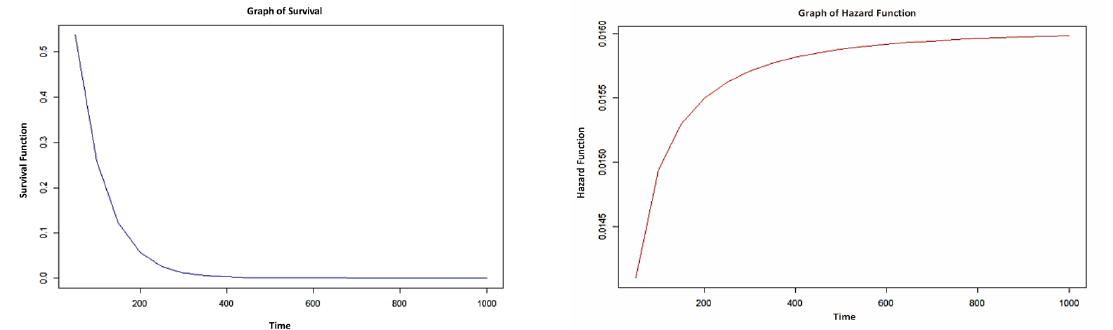
Fig. 5 . Graph of Survival function and Hazard function by EM